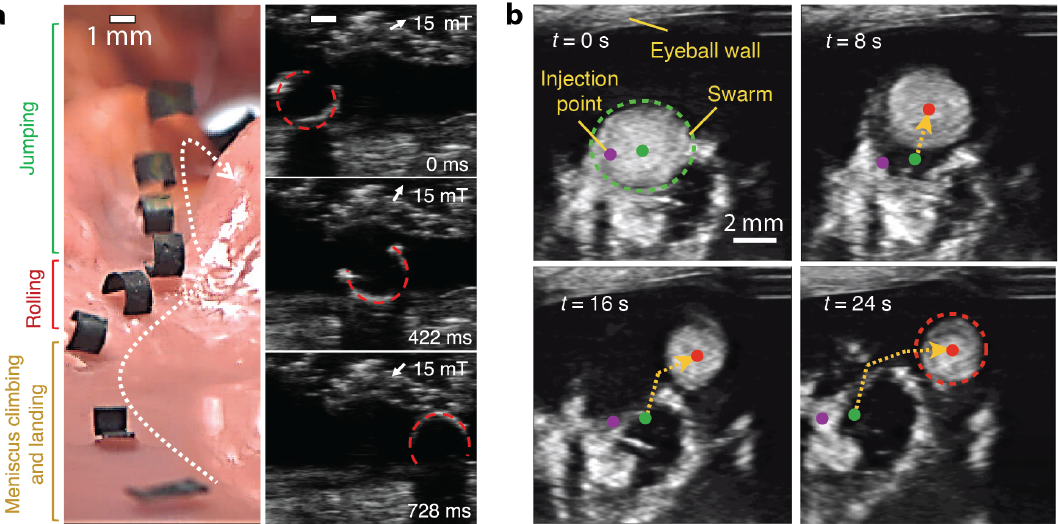
Figure 4. Exemplar small-scale magnetic robots imaged by US. ( a ) A millimetre-scale soft magnetic robot moved inside a phantom made by ex vivo chicken tissue. Reproduced with permission from [84]. Copyright © 2018, Springer Nature. ( b ) Navigated locomotion of a swarm of small-scale magnetic robots inside a bovine eyeball with US imaging feedback. Reproduced with permission under a Creative Commons Attribution 4.0 International License